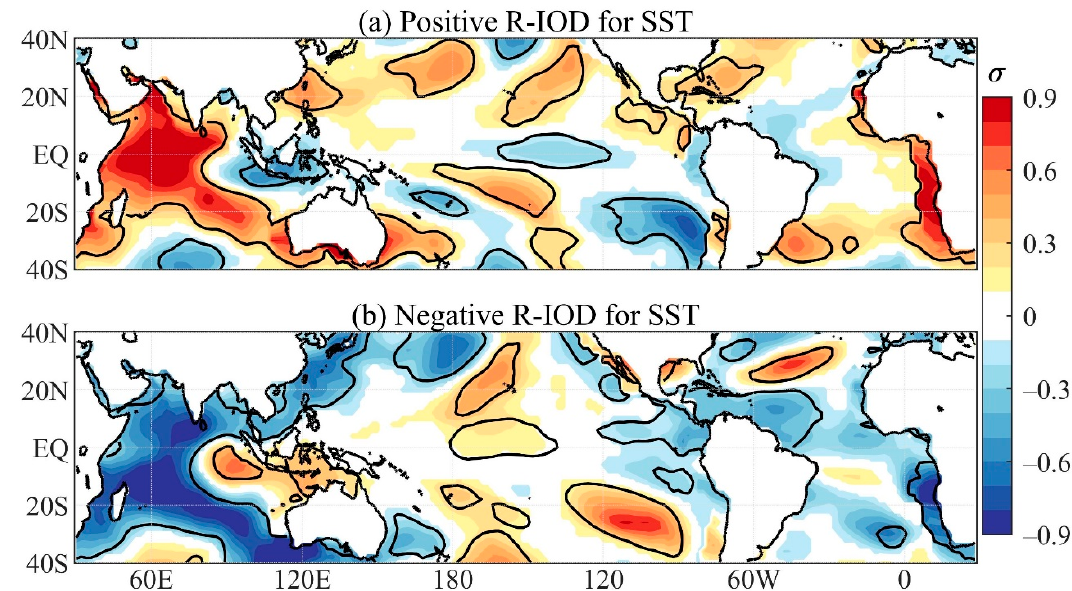
Figure 8. Composite of the residual SST anomalies during austral spring for the: ( a ) positive R-IOD; and ( b ) negative R-IOD. In this Figure, residual means without the TPO effects. Graphical display is the same as that in Figure 3.